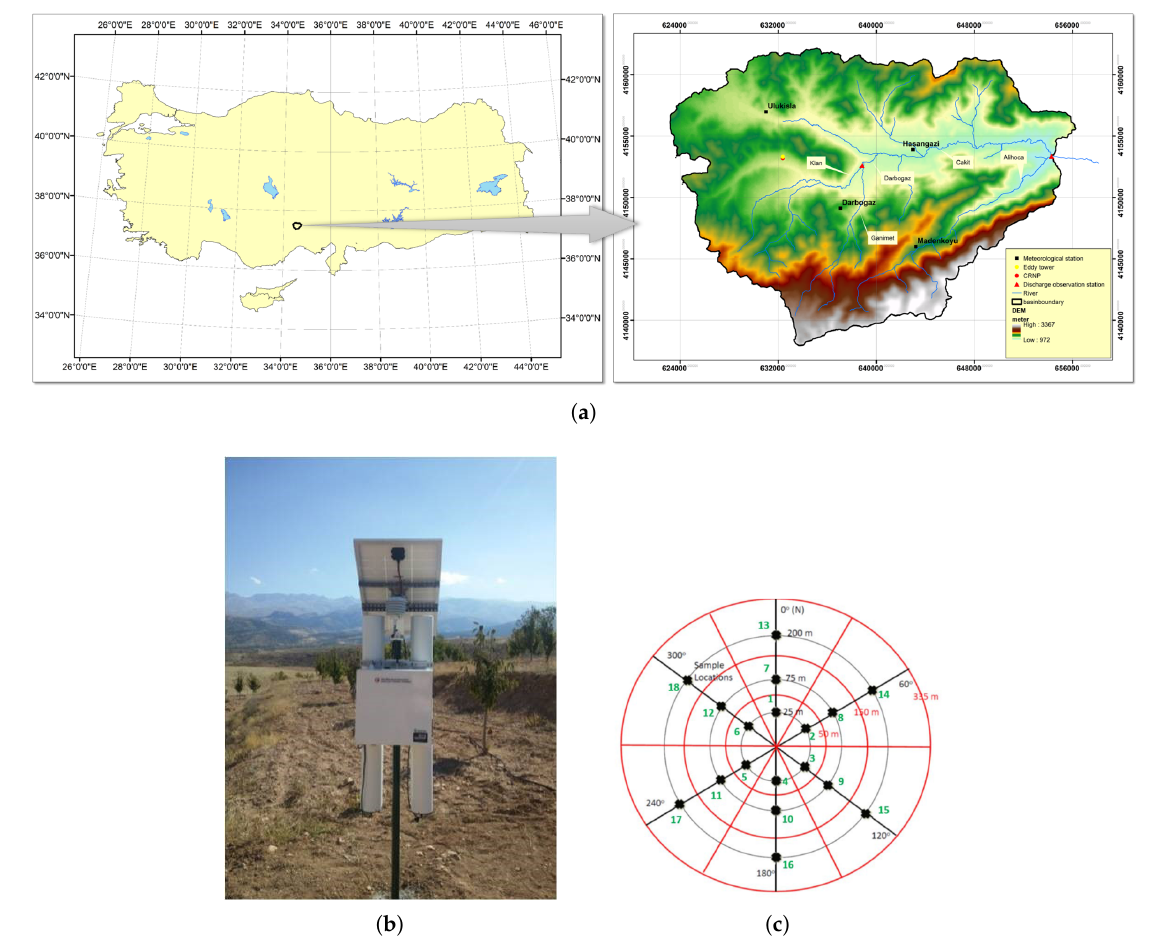
Figure 2. Cosmic Ray Neutron Probe Installed at Çakıt Basin-Turkey ( a ) Location of the Çakıt Basin ( b ) Cosmic Ray Neutron Probe ( c ) Soil Sampling Locations. (Black: Soil sample location distances from the center in meter, Green: Sample